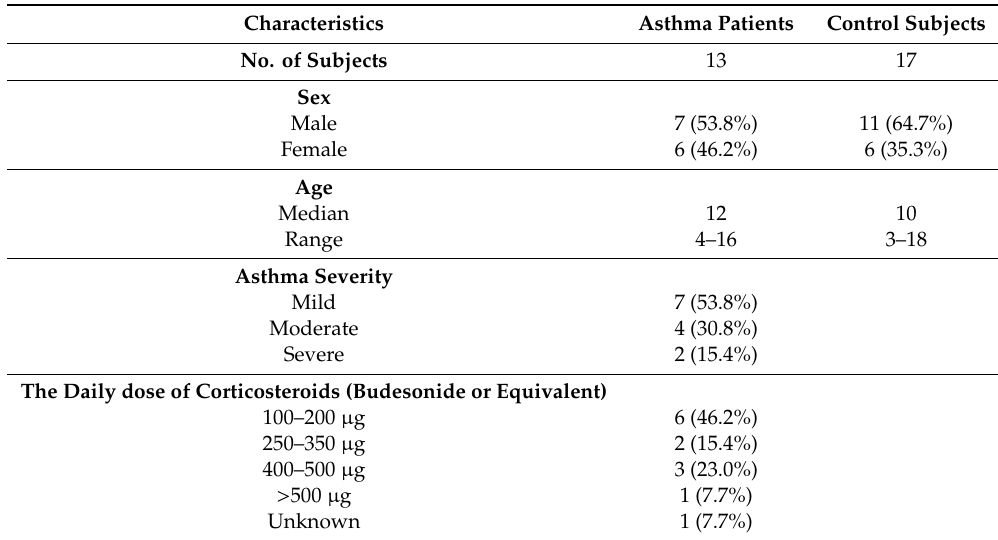
Table 1. Characteristics of the